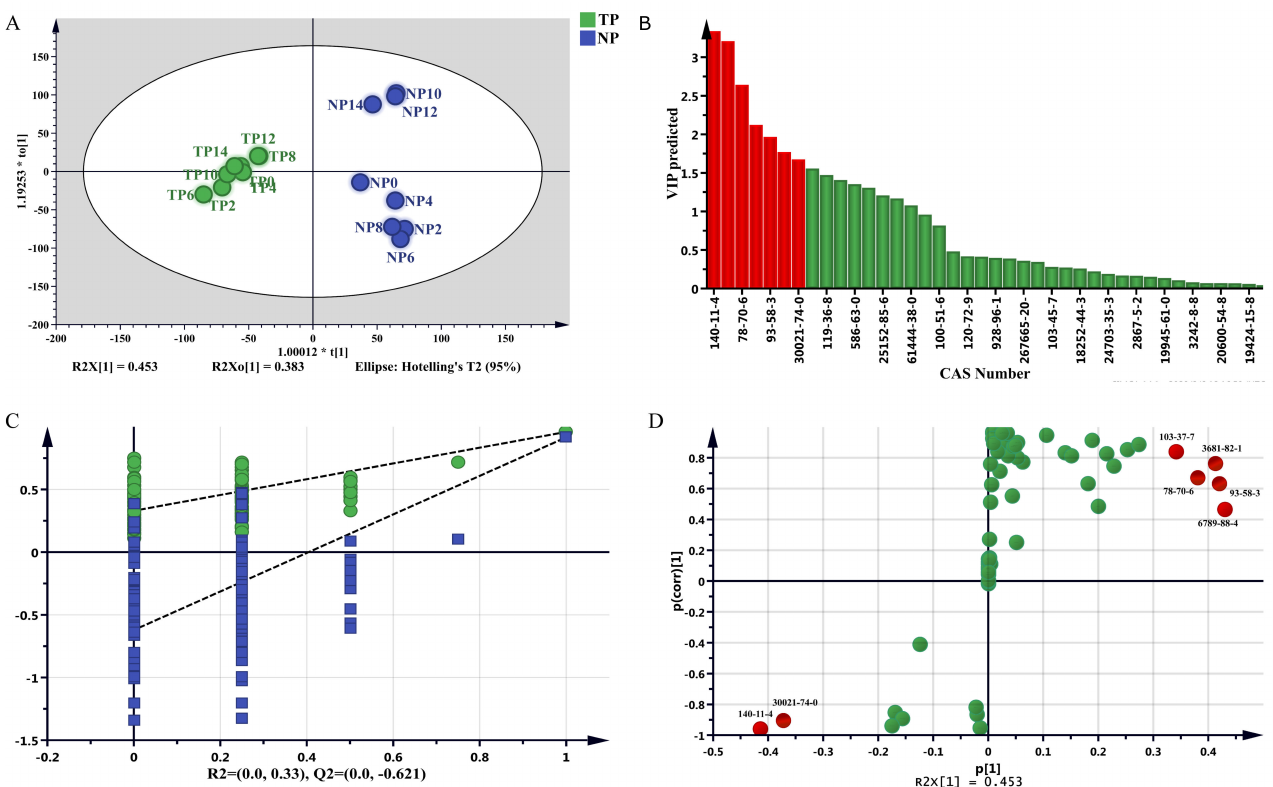
Figure 4. Comparative analysis of volatile components of TP and NP. ( A ) OPLS-DA score plot. ( B ) VIP plot. ( C ) permutation tests plot. ( D ) S-plot. The color in B and D means that differential volatile component is marker in green color; those significant differential volatile components with a VIP > 1 and FC > 1.5 or <0.67 ( p < 0.05) marker in red